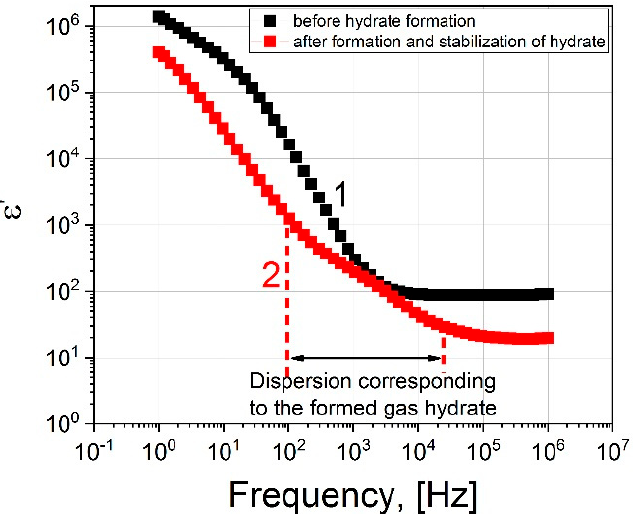
Figure 4. The real part of the dielectric spectrum: black squares correspond to the spectrum before the hydrate formation; red squares represent the spectrum after hydrate formation at 273 K, 9 MPa.